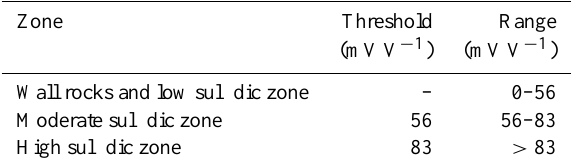
Table 1. Threshold values obtained by using the C - V method based on Chargeability (mVV − 1 ) in Nowchun deposit.